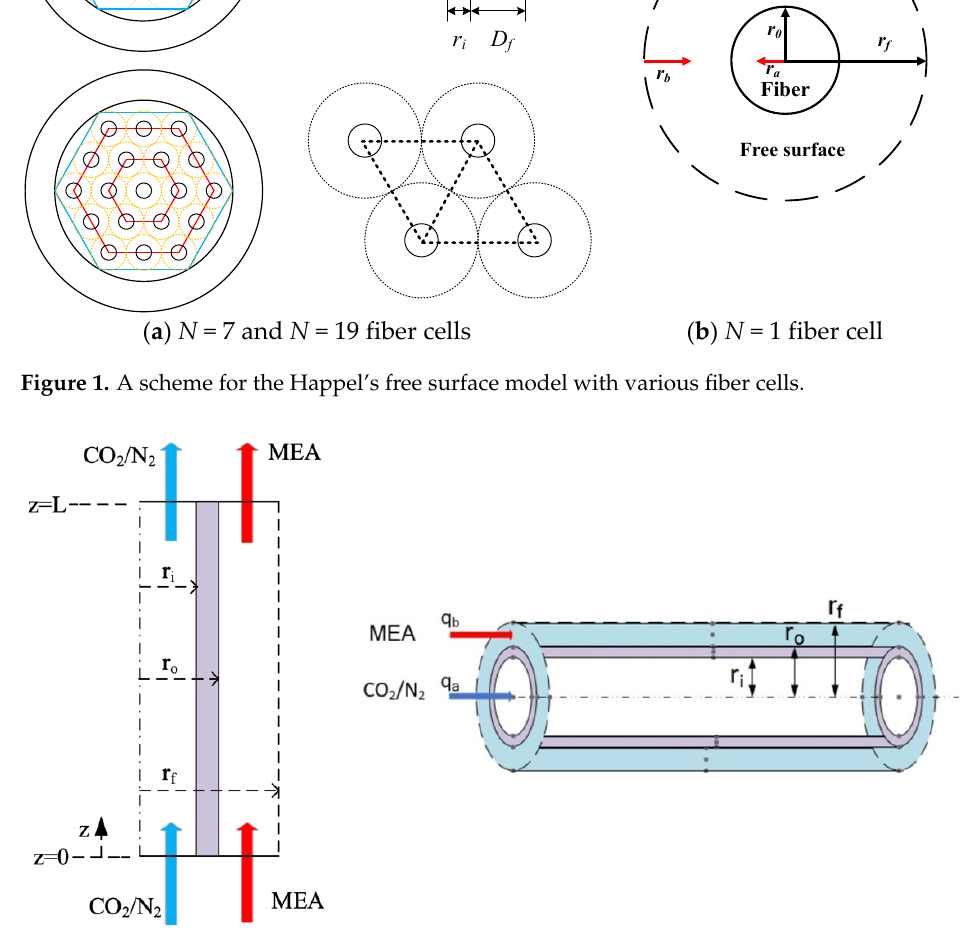
Figure 2. Three regions for modeling CO 2 absorption in hollow-fiber membrane contactors.